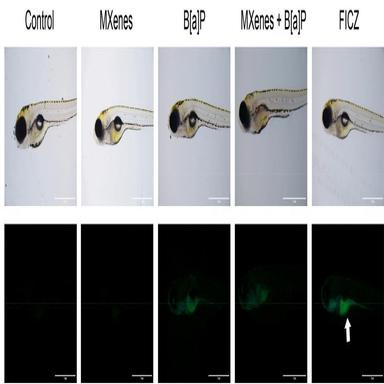
Monitoring cyp1a induction using transgenic zebrafish. (A) The average fluorescence intensity in eGFP:cyp1a transgenic zebrafish embryos after exposure for 24 h to MXenes (80 mg/L), BP (1 mg/L), and FICZ (1 μM) (25 individuals per sample). Data are presented as mean values ± S.D. of three independent experiments. One-way ANOVA with Tukey's multiple comparison test was used to analyze statistical differences between the exposures (p < 0.05, p < 0.01, p < 0.001, p < 0.0001). (B) Representative fluorescence im